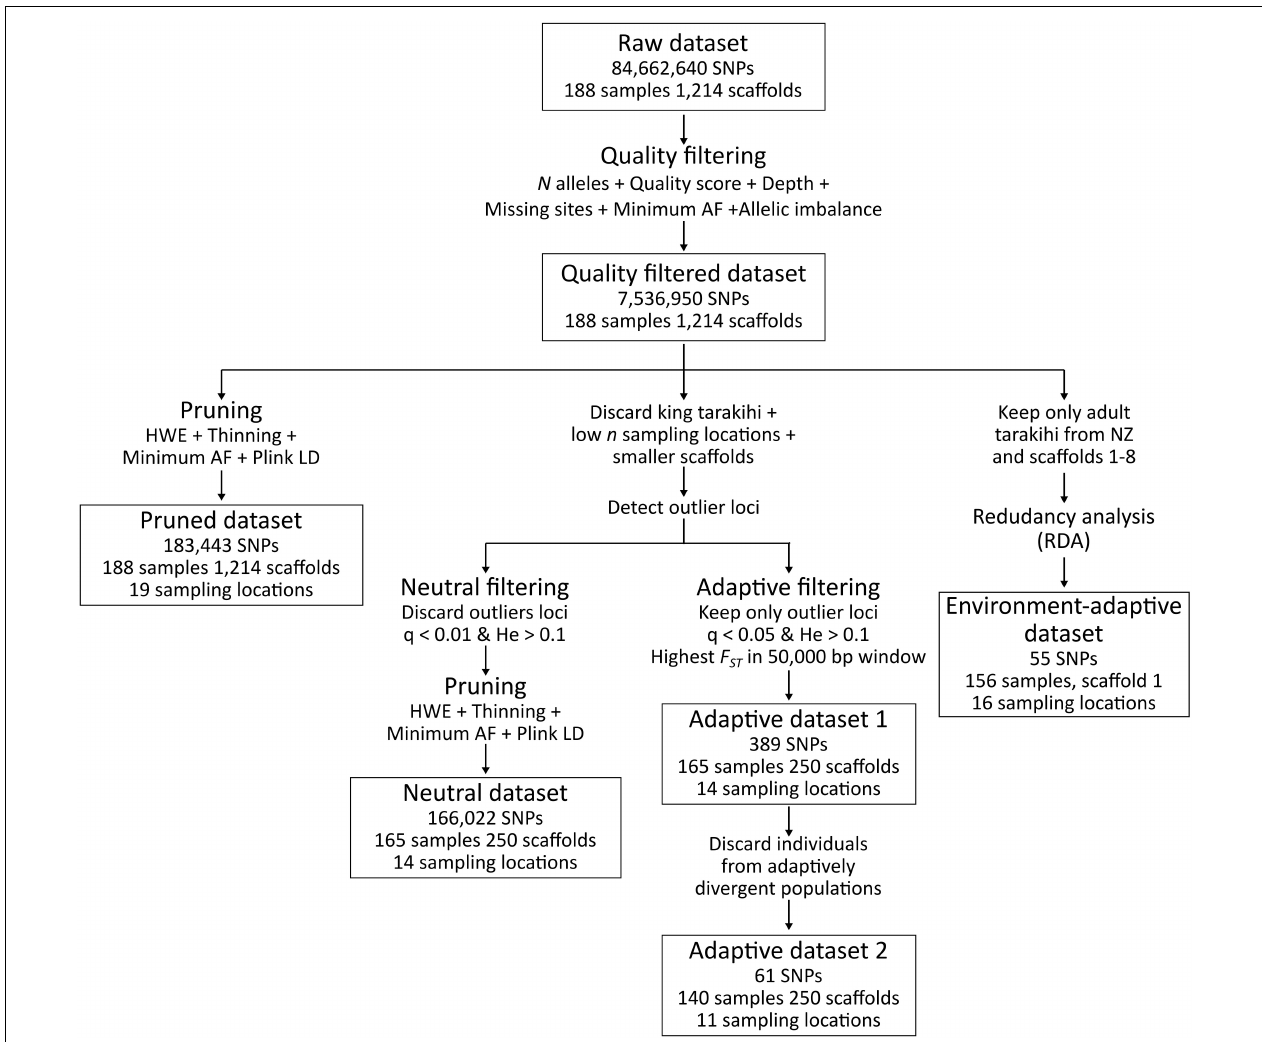
FIGURE 3 | Variant filtering pipeline applied on the raw SNP dataset, resulting in one intermediary dataset (quality-filtered) and five final datasets (pruned, neutral, adaptive 1, adaptive 2, and